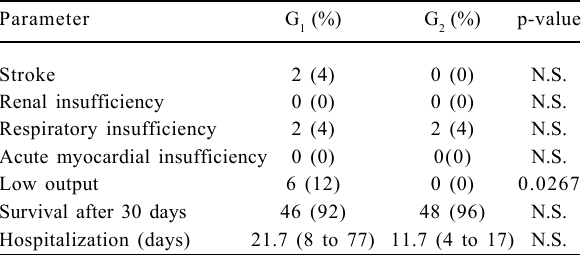
and 96% from group G 1